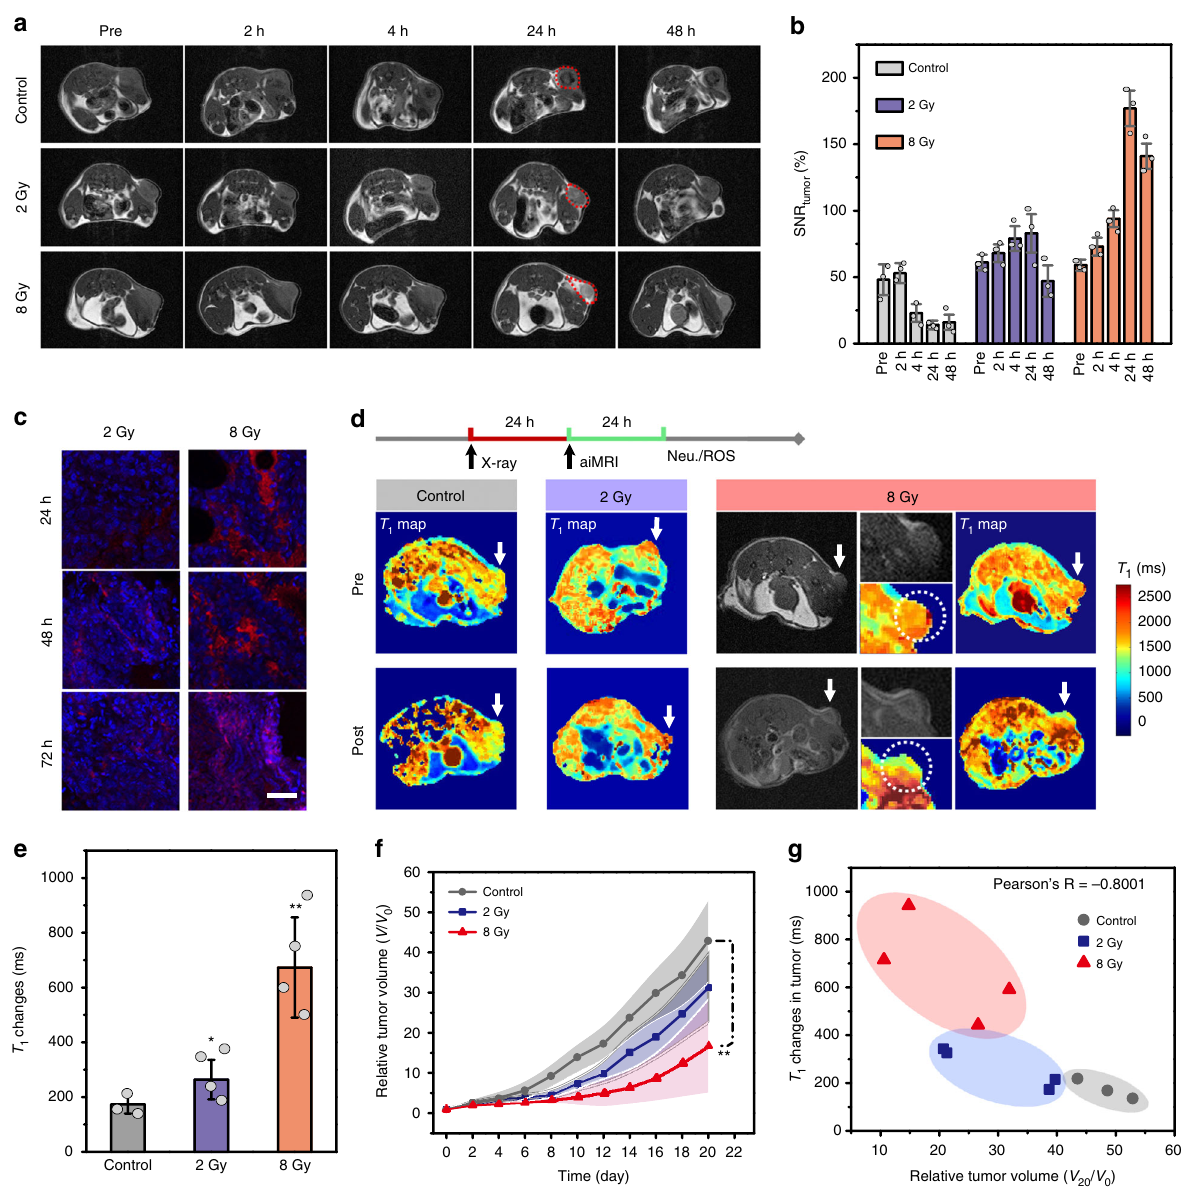
Fig. 4 The aiMRI in mouse U87MG tumor models. a The T 1 MRI study of mouse tumors after receiving 2 or 8 Gy X-ray irradiation and control, using IO-Gd NVs as contrast agents. The T 1 MRI at 2, 4, 24, and 48 h post injection (p.i.) were acquired. Red dashed circles indicate the sharp contrast in tumors at 24 h p.i. b Semi-quantitative analysis of the signal-to-noise ratio (SNR) in tumors. c Immuno fl uorescence staining of the MPO levels in tumors at different time points after receiving X-ray irradiation ( n = 3 biologically independent mice). d The pre- and post-contrast T 1 phantom images and the quantitative T 1 relaxation maps of mouse tumors. Radiotherapy (RT) was performed 24 h prior to the aiMRI acquisition. White arrows indicate mouse tumors. Magni fi ed images indicate the tumor (white dotted circle). e Quantitative T 1 relaxation time changes in mouse tumors. * P = 0.031 and ** P = 0.0054 ( n = 3 or 4 biologically independent mice indicated as dot plots, one-tailed homoscedastic t -test). f Tumor growth curves of the mouse groups ( n = 5 biologically independent mice, ** P = 0.0032, one-tailed paired t-test). The shadow indicates the errors. g Plotting of the T 1 relaxation time changes at 24 – 48 h and the relative tumor volume changes at day 20 after RT. The Pearson ’ s correlation coef fi cient R is calculated to be − 0.8001. All error bars indicate mean ± SNR tumor is possibly due to the diffusion of Gd species after the IO-Gd NVs as contrast agents. The results show that the intravenously injected IO-Gd NVs turned into negative contrast decomposition of the IO-Gd NVs. However, mouse tumors in mouse tumors without irradiation (Fig. 4a). The accumulation receiving a low dose X-ray irradiation (2 Gy) show little T 1 MRI signal changes and SNR tumor . The use of Gd NVs and IO NVs as of IO-Gd NVs led to gradually increased negative contrast in contrast agents resulted in always ON and always OFF tumor with a maximum reached at 24 h p.i. The semi-quantitative phenomenon in T 1 MRI of mouse tumors receiving 8 Gy X-ray analysis also reveals that the SNR tumor decreases to a factor of 3.4 at 24 h p.i. compared with that of pre-contrast images (Fig. 4b). In irradiation, which are consistent with the aiMRI in vitro and contrast, mouse tumors receiving 8 Gy X-ray irradiation show in vivo mouse in fl ammation models (Supplementary Fig. 16). We bright contrast at 24 h p.i. with SNR tumor of 177%, which slightly further explored the differences of in fl ammatory responses decreases to 141% at 48 h p.i. (Fig. 4a, b). The slightly decreased between mouse tumors receiving different doses of irradiation.